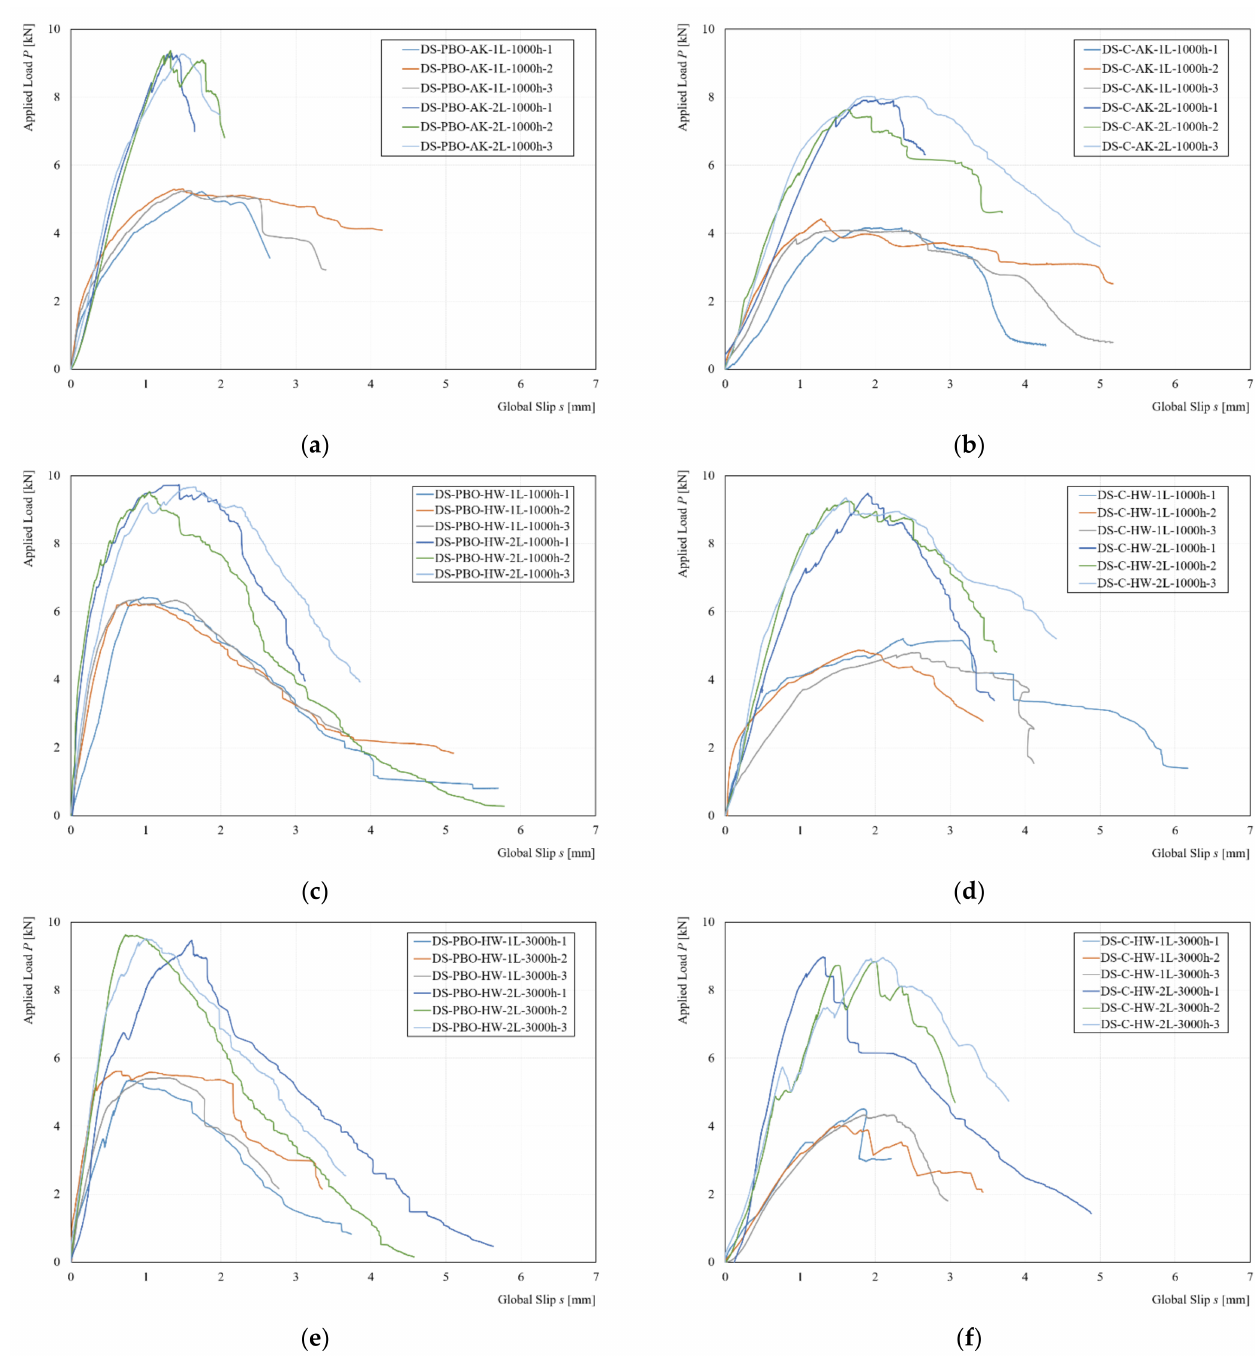
Figure 9. Comparison between experimental curve: ( a ) AK for PBO-FRCM, ( b ) AK for C-FRCM, ( c ) HW at 1000 h for PBO-FRCM, ( d ) HW at 1000 h for C-FRCM, ( e ) HW at 3000 h for PBO-FRCM. and ( f ) HW at 1000 h for